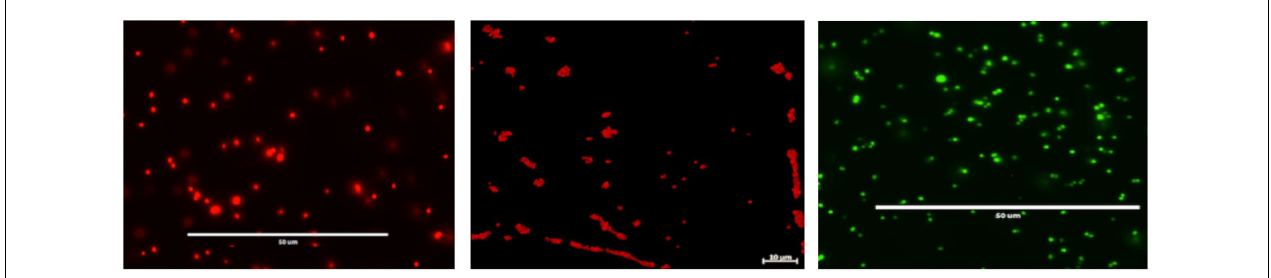
FIGURE 4 | Fluorescent microscopy of cultured S. aureus SH1000 strains containing pSRFPS1 (left) , pSFRFPS1 (middle) , and pSGFPS1 (right ).